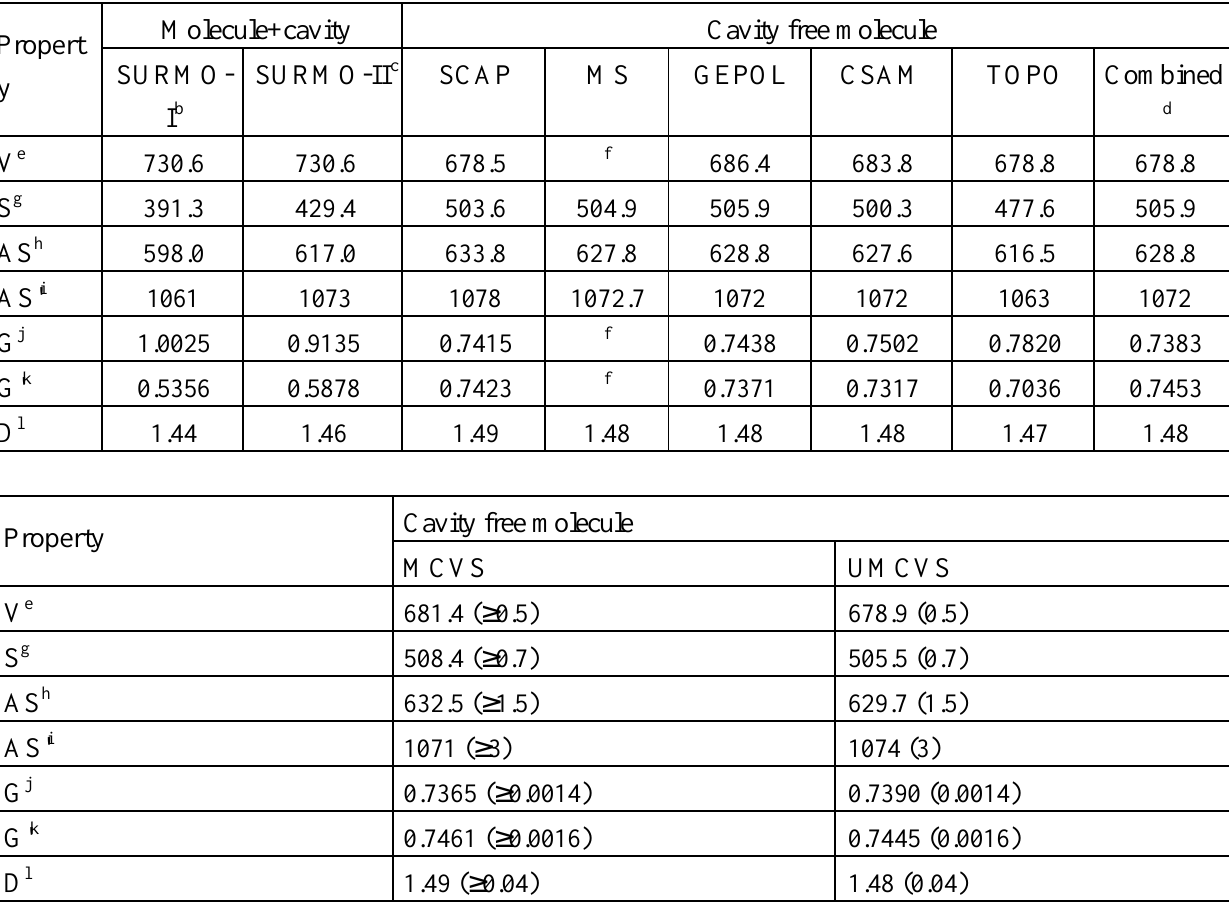
Table 2. Geometric descriptors and topological indices for fullerene-82 calculated with different methods. a